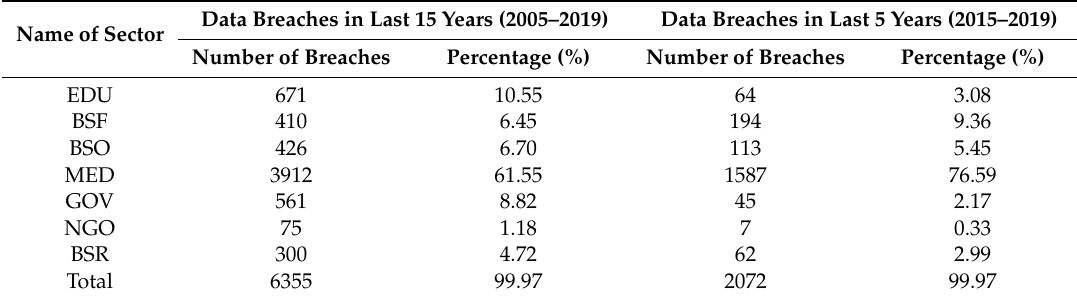
Table 1. Representation of Data Breaches by